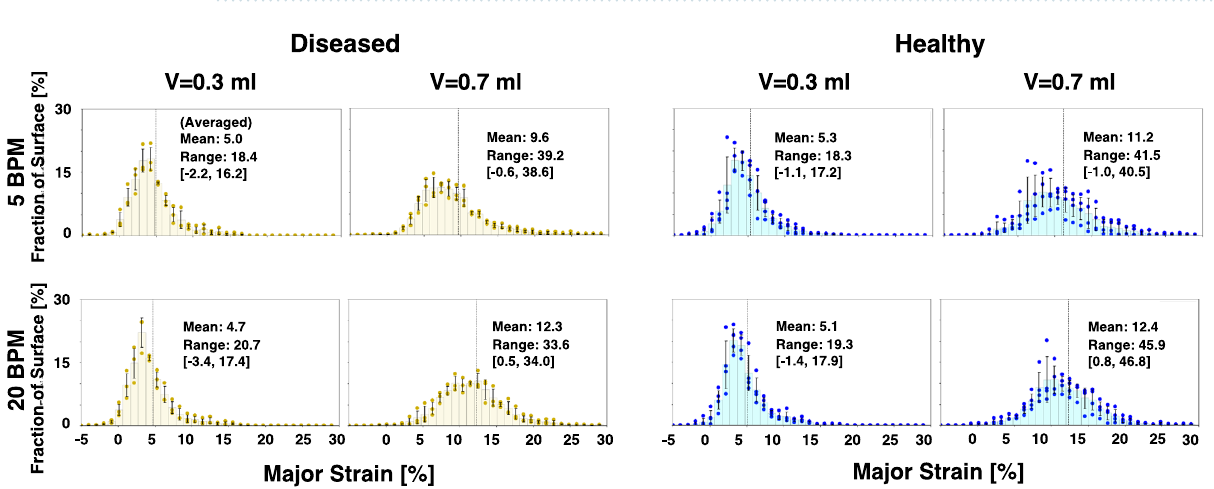
Figure 3. Diseased (gold) and healthy (blue) mouse whole lung strains obtained via DIC across specimens (average ± standard deviation of the individual mice values shown). The histograms depict the fraction of the surface of which strain values occurred, for applied volumes of 0.3 and 0.7 ml, and at the two inflation frequencies of 5 and 20 BPM. In addition, the whole lung surface’s mean and range strain values are